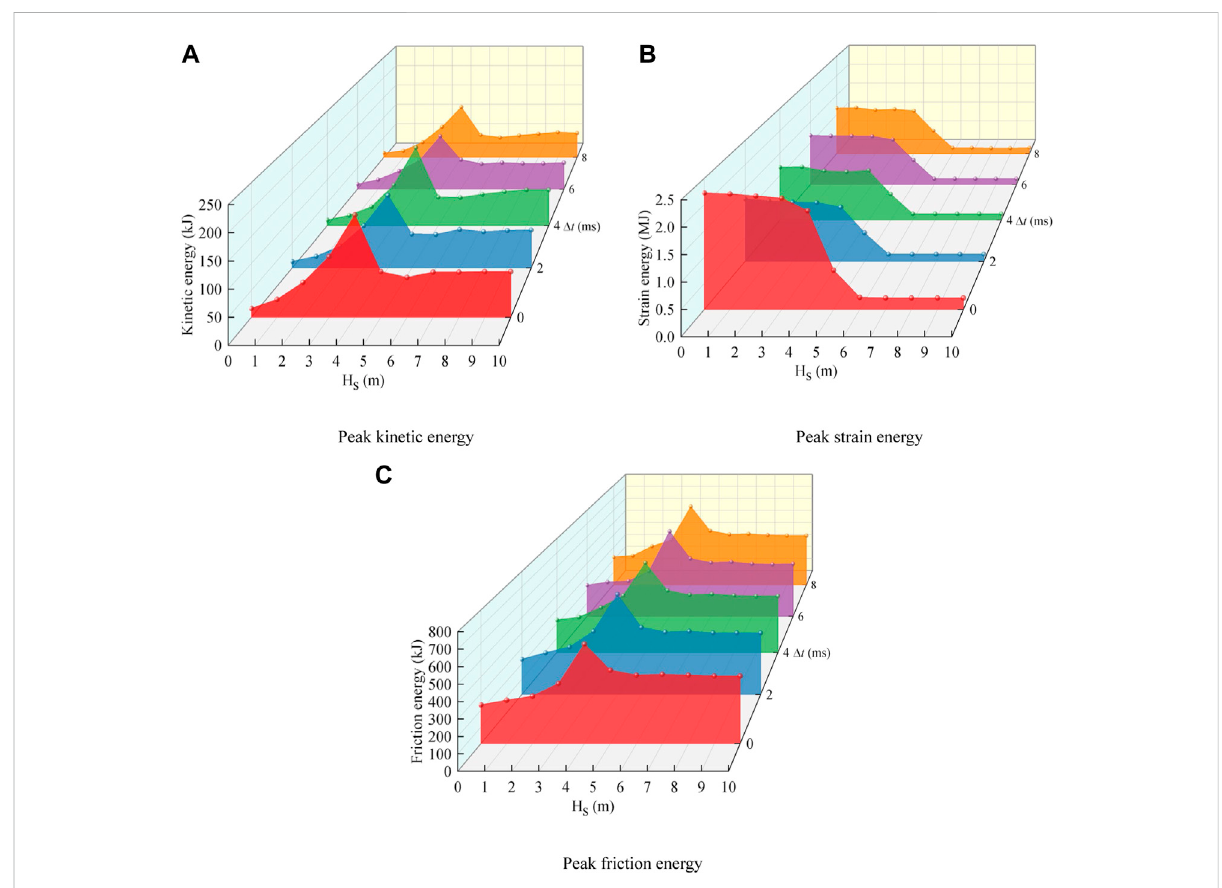
FIGURE 11 Peak energy variation curves, (A) Peak kinetic energy, (B) Peak strain energy, (C) Peak friction